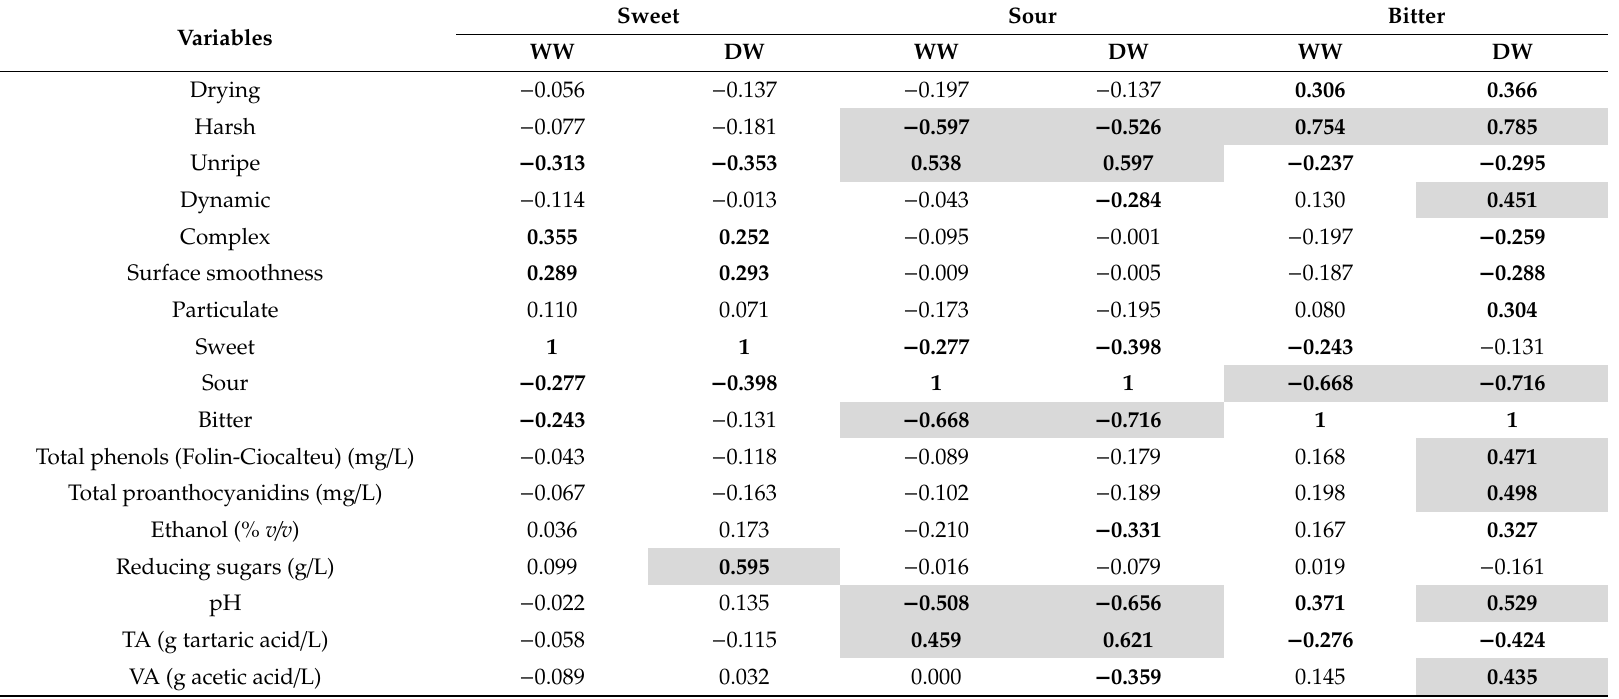
Table 6. Correlation coe ffi cients (Pearson) between taste and chemical variables. Comparison between WW and